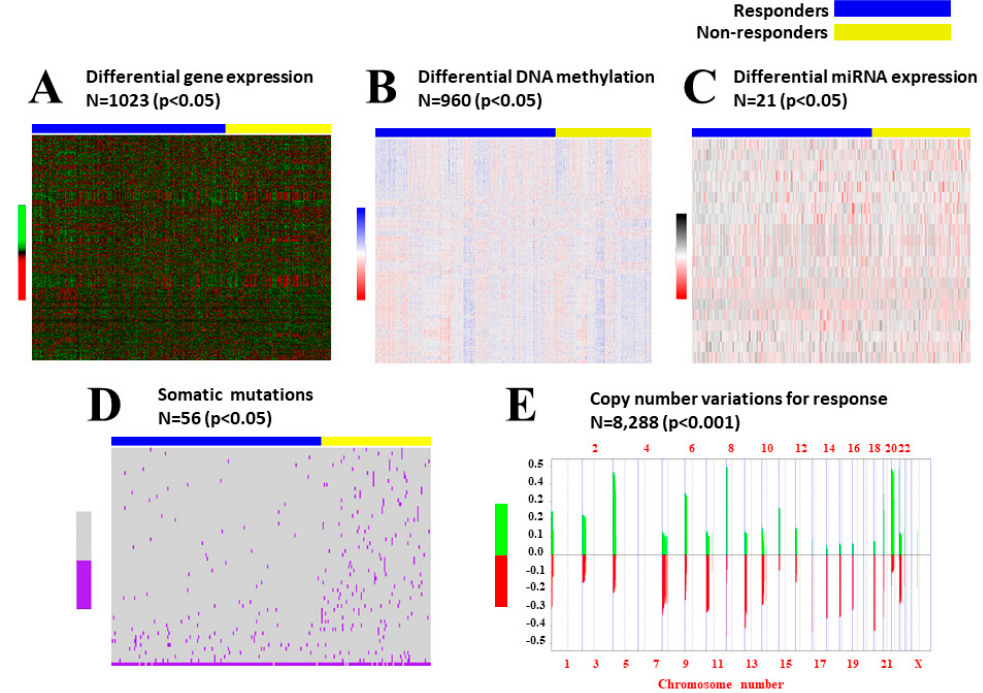
Figure 1. Univariate Analysis between Responders and Non-Responders. Heatmaps and graphics of molecular variables that were different between groups of responders and non-responders, with color codes and significance levels for each class of data. These variables were used for the integrative cluster analysis with iClusterPlus : ( A ) Differentially expressed genes; ( B ) Differentially methylated promoters; ( C ) Differentially expressed miRNAs; ( D ) Somatic mutations; ( E ) Altered gene copy numbers: green means gain of copy number, red is loss of copy